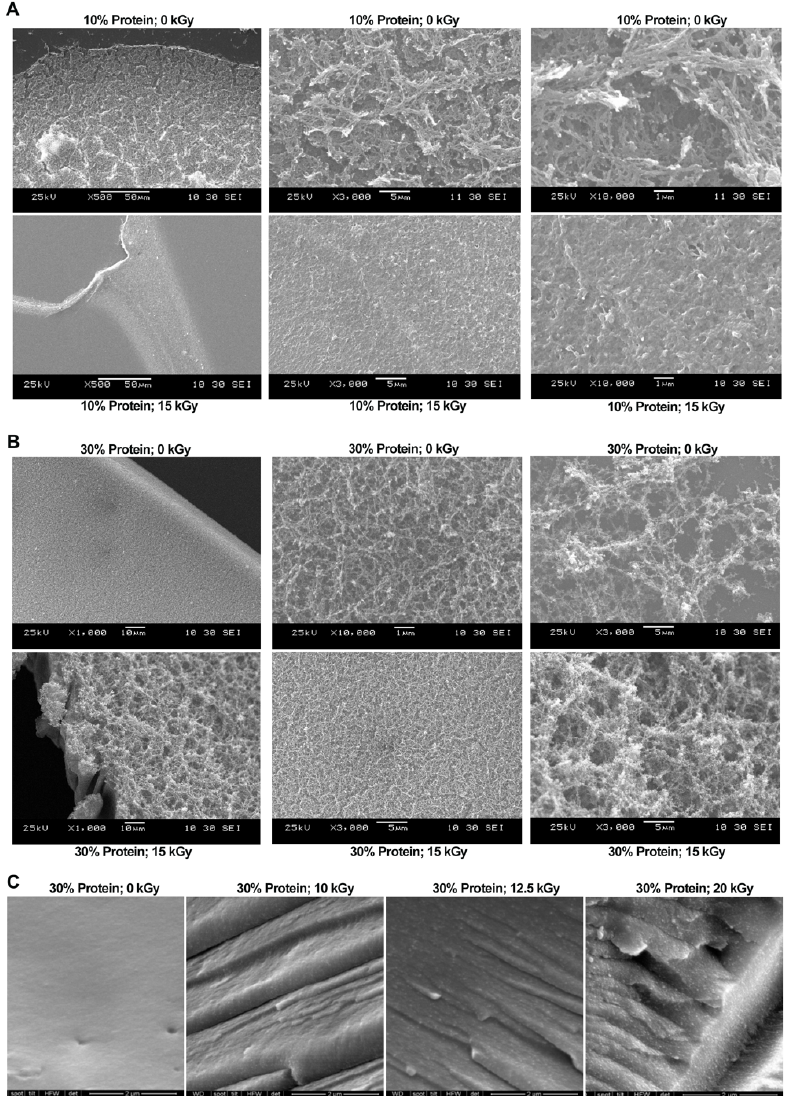
Figure 3. Comparison of SEM images of WPI solutions (30% protein) before and after gamma radiation treatment. ( A ) Comparison of WPI solution (10% protein) untreated or treated by 15 kGy gamma radiation. ( B ) Comparison of WPI solution (30% protein) united or treated by 15 kGy. ( C ) Comparison of WPI solution (30%) untreated or treated by 10, 12.5, 20 kGy gamma radiation.